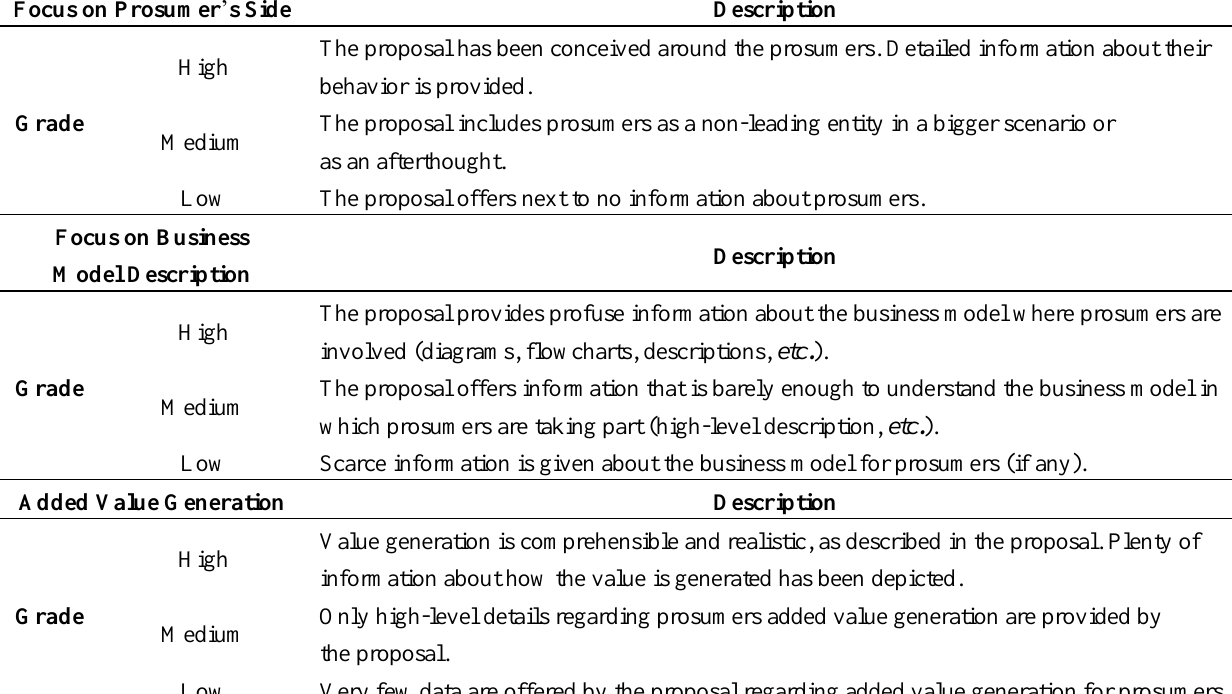
Table 2. Non-functional requirements